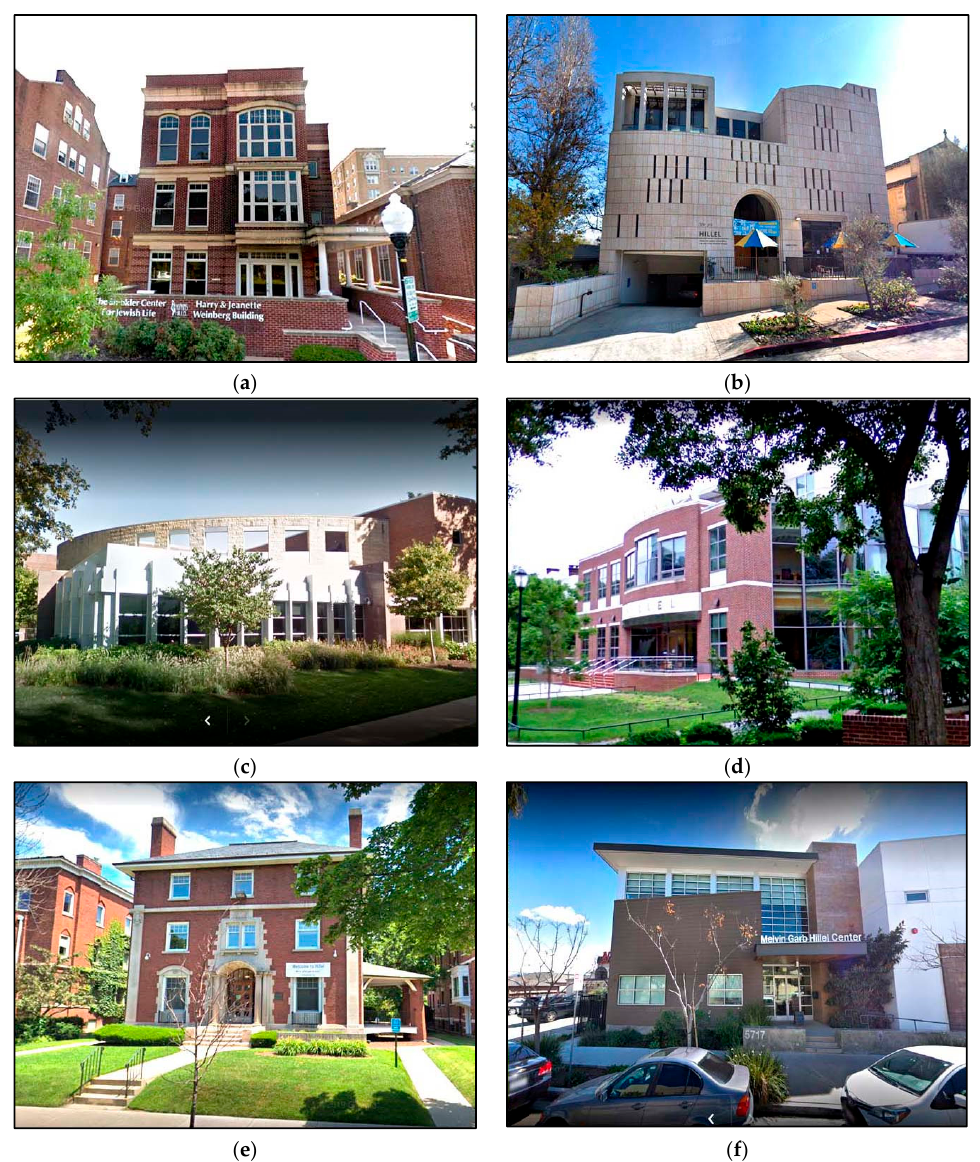
Figure 1. Examples of contemporary Jewish Student Centers. ( a ) Smokler Center for Jewish Life, Johns Hopkins University, Baltimore, MD; ( b ) Rabin Hillel Center for Jewish Life, UCLA, Los Angeles, CA; ( c ) The Cohen Center for Jewish Life, University of Illinois, Champaign-Urbana, IL; ( d ) Hillel at Steinhardt Hall, University of Pennsylvania, Philadelphia, PA; ( e ) Newberger Hillel Center, University of Chicago, Chicago, IL; ( f ) Melvin Garb Hillel Center, San Diego State, San Diego, CA. Image